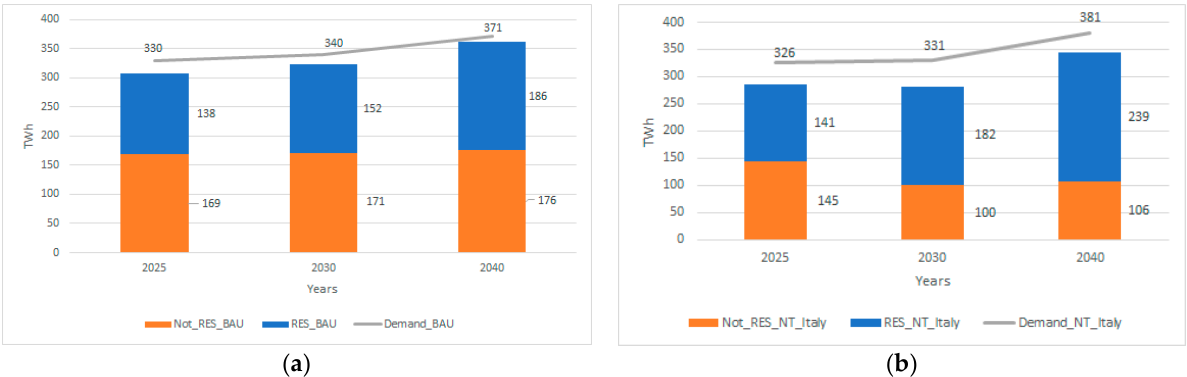
Figure 6. Comparison between RES and Not RES production with demand, Italy scenarios: ( a ) BAU and ( b ) NT.